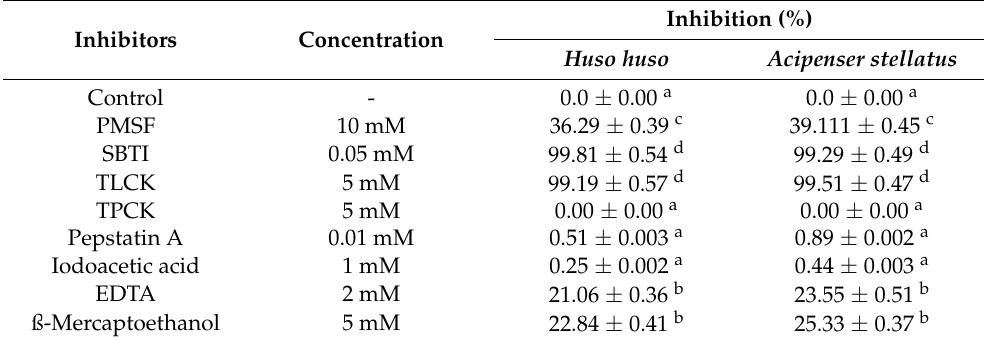
Inhibition (%) Huso huso Acipenser stellatus